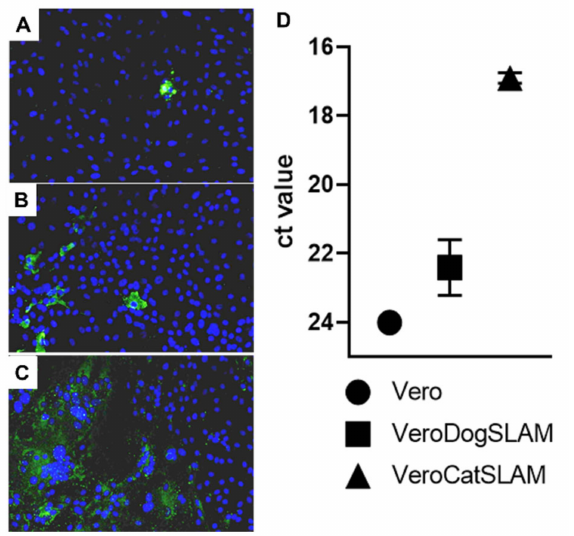
Figure 2. FeMV-GT2 growth 8 days post infection on ( A ) Vero, ( B ) VeroDogSLAM, and ( C ) VeroCat- SLAM cells. Green immunofluorescence represents FeMV nucleoprotein signal. Cell nuclei were stained with Hoechst 33342 dye (blue) and FeMV was stained with anti-FeMV-N antibody followed by Alexa 488 conjugated secondary antibody (green). Pictures were taken with a magnification of 100 × . ( D ) FeMV RNA loads measured by RT-qPCR. Mean values of two distinct experiments and the standard deviation are shown.